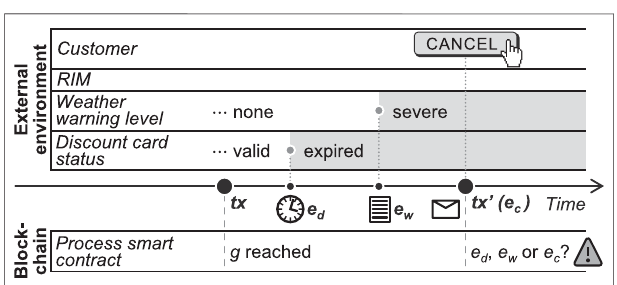
FIGURE 2 | Indeterminate behavior of a process smart contract due to temporal gaps between transactions.